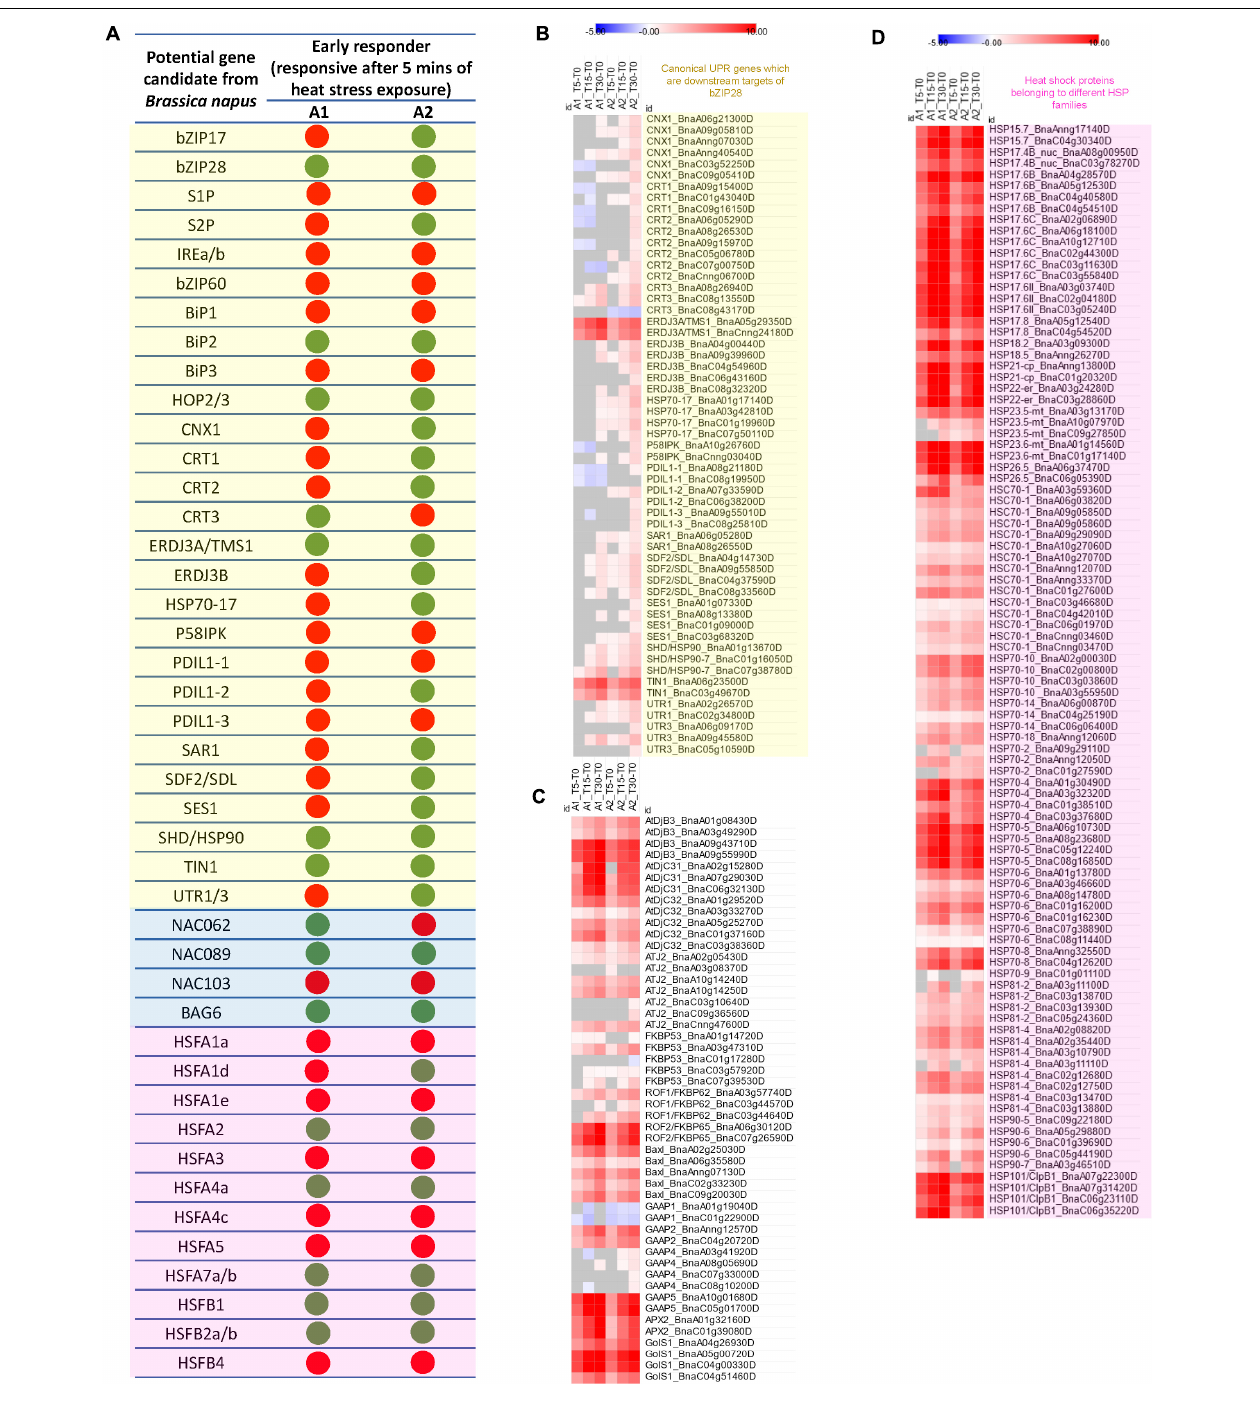
Frontiers in Plant Science |